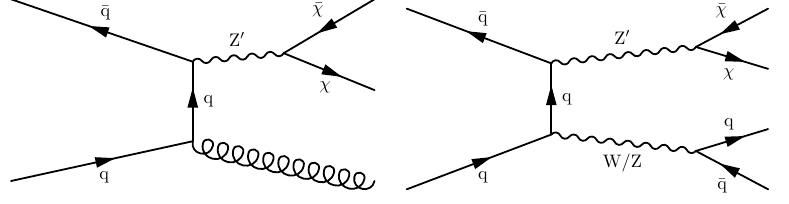
Figure 1 . Leading order Feynman diagrams of monojet (left) and mono-V (right) production and decay of a spin-1 mediator.